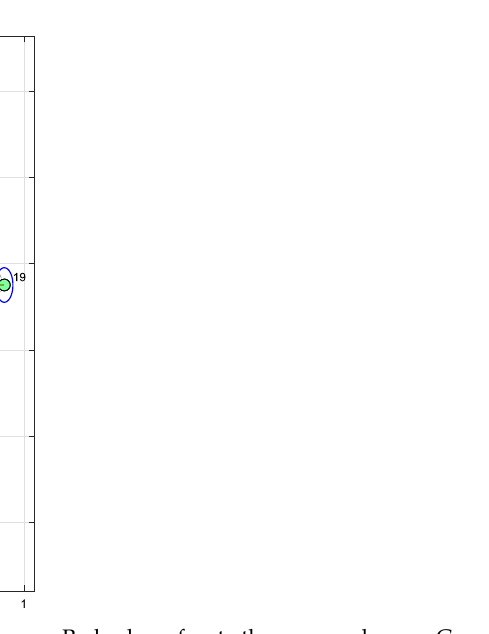
Figure 15. Influence of Emotional States into Groups. Red color refers to the proposed group Gaussian function for group